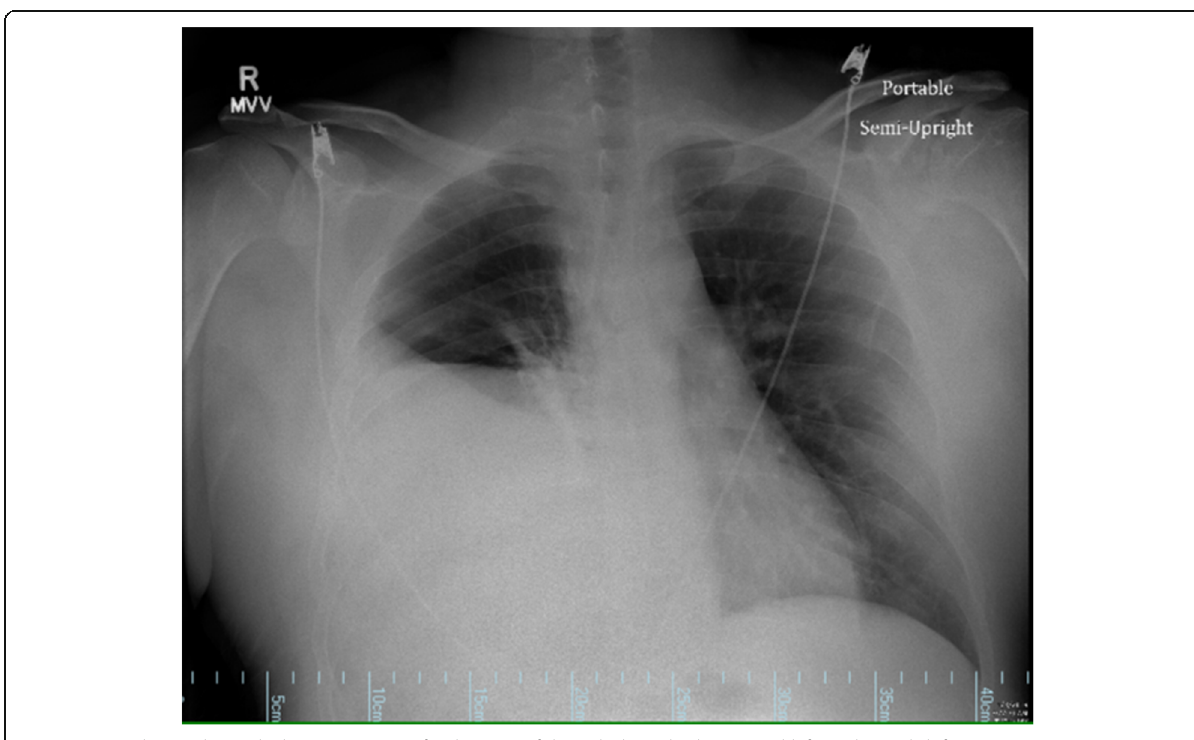
Fig. 1 Pre-op chest radiograph showing nonspecific elevation of the right hemidiaphragm and left mediastinal